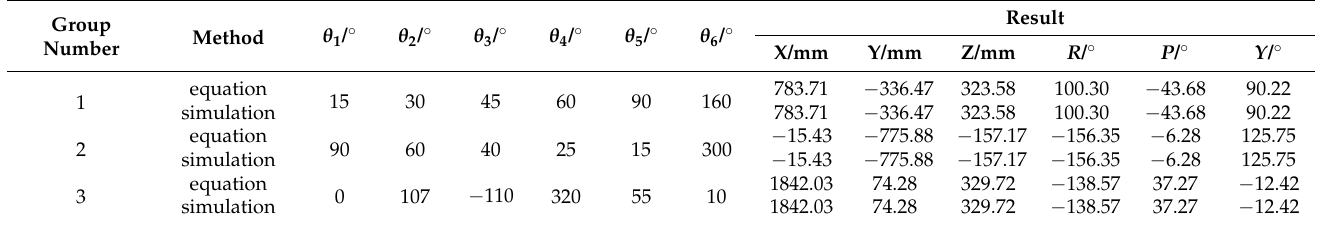
Table 2. The posture teaching results and simulation comparison results of the end effector.